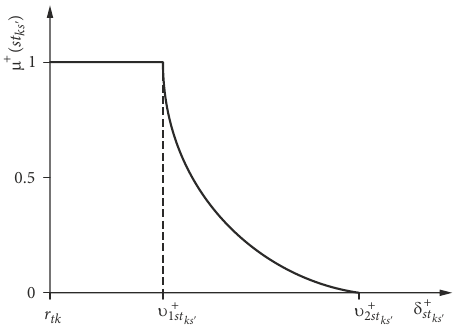
Figure 7. Satisfaction function on emergent failure’s repair in sub-model